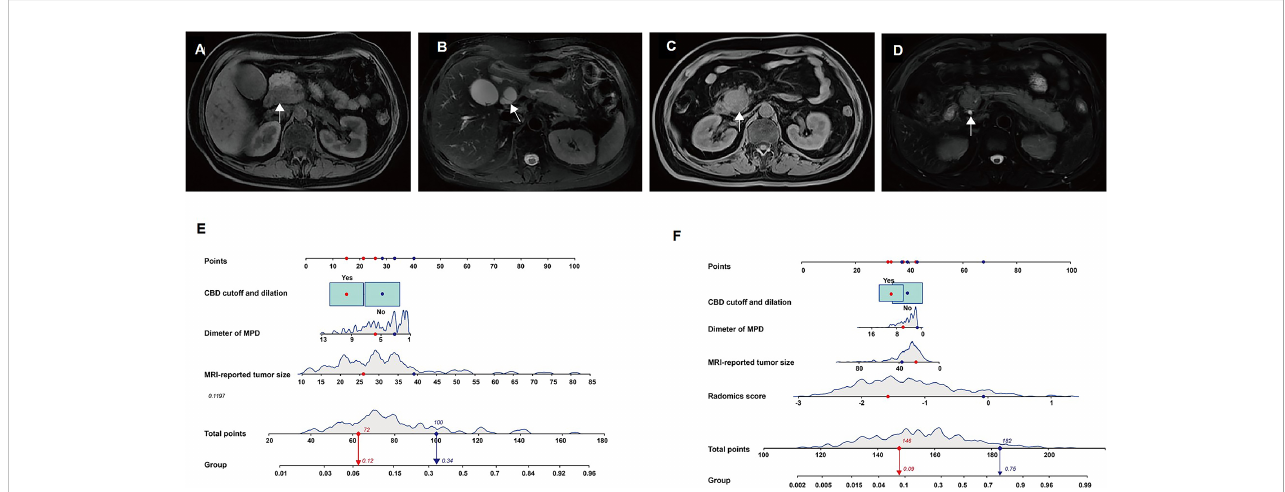
FIGURE 5 The two models accurately differentiate pancreatic adenosquamous carcinoma (PASC) from PDAC. Case 1: a 69-year-old woman with pathologically con fi rmed pancreatic ductal adenocarcinoma (PDAC). (A) Axial T1W image shows a hypoattenuated mass with an MRI-reported tumor size of 27 mm located at the pancreatic head (white arrow). (B) . Axial T2W image shows common bile duct (CBD) cutoff and dilation (white arrow). Case 2: a 54-year- old man with pathologically con fi rmed PASC. (C) Axial T1W image shows a hypoattenuated mass with an MRI-reported tumor size of 39 mm located at the pancreatic head (white arrow). (D) . The axial T2W image shows the typical CBD (white arrow). (E) According to the MRI model, the prediction probabilities of PASC are 0.12 (red arrow) and 0.34 (blue arrow) in cases 1 and 2, respectively. (F) According to the radiomics model, the prediction